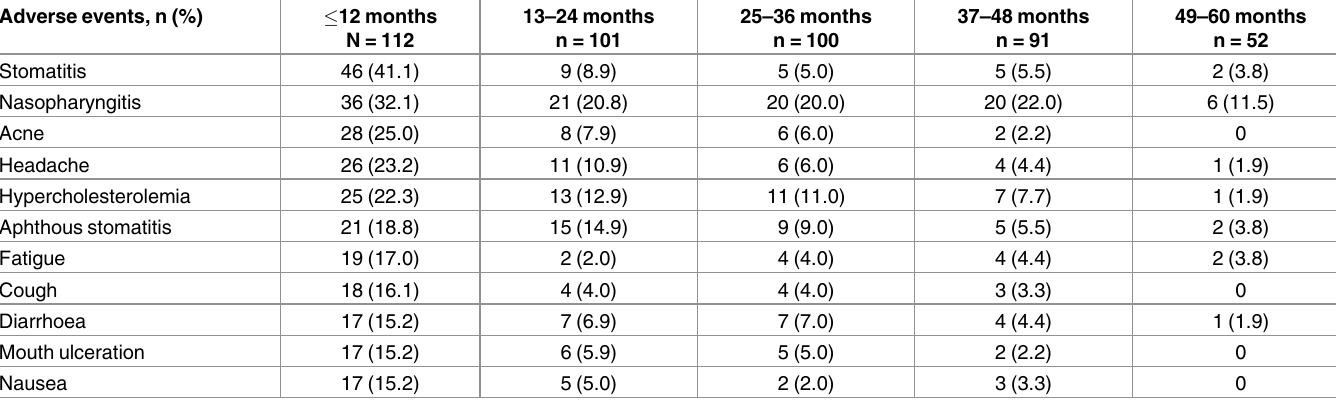
Table 3. Adverseevents by preferredterm regardless of relationship to study drug and by year of emergence( > 15%of patients). Adverse events, n